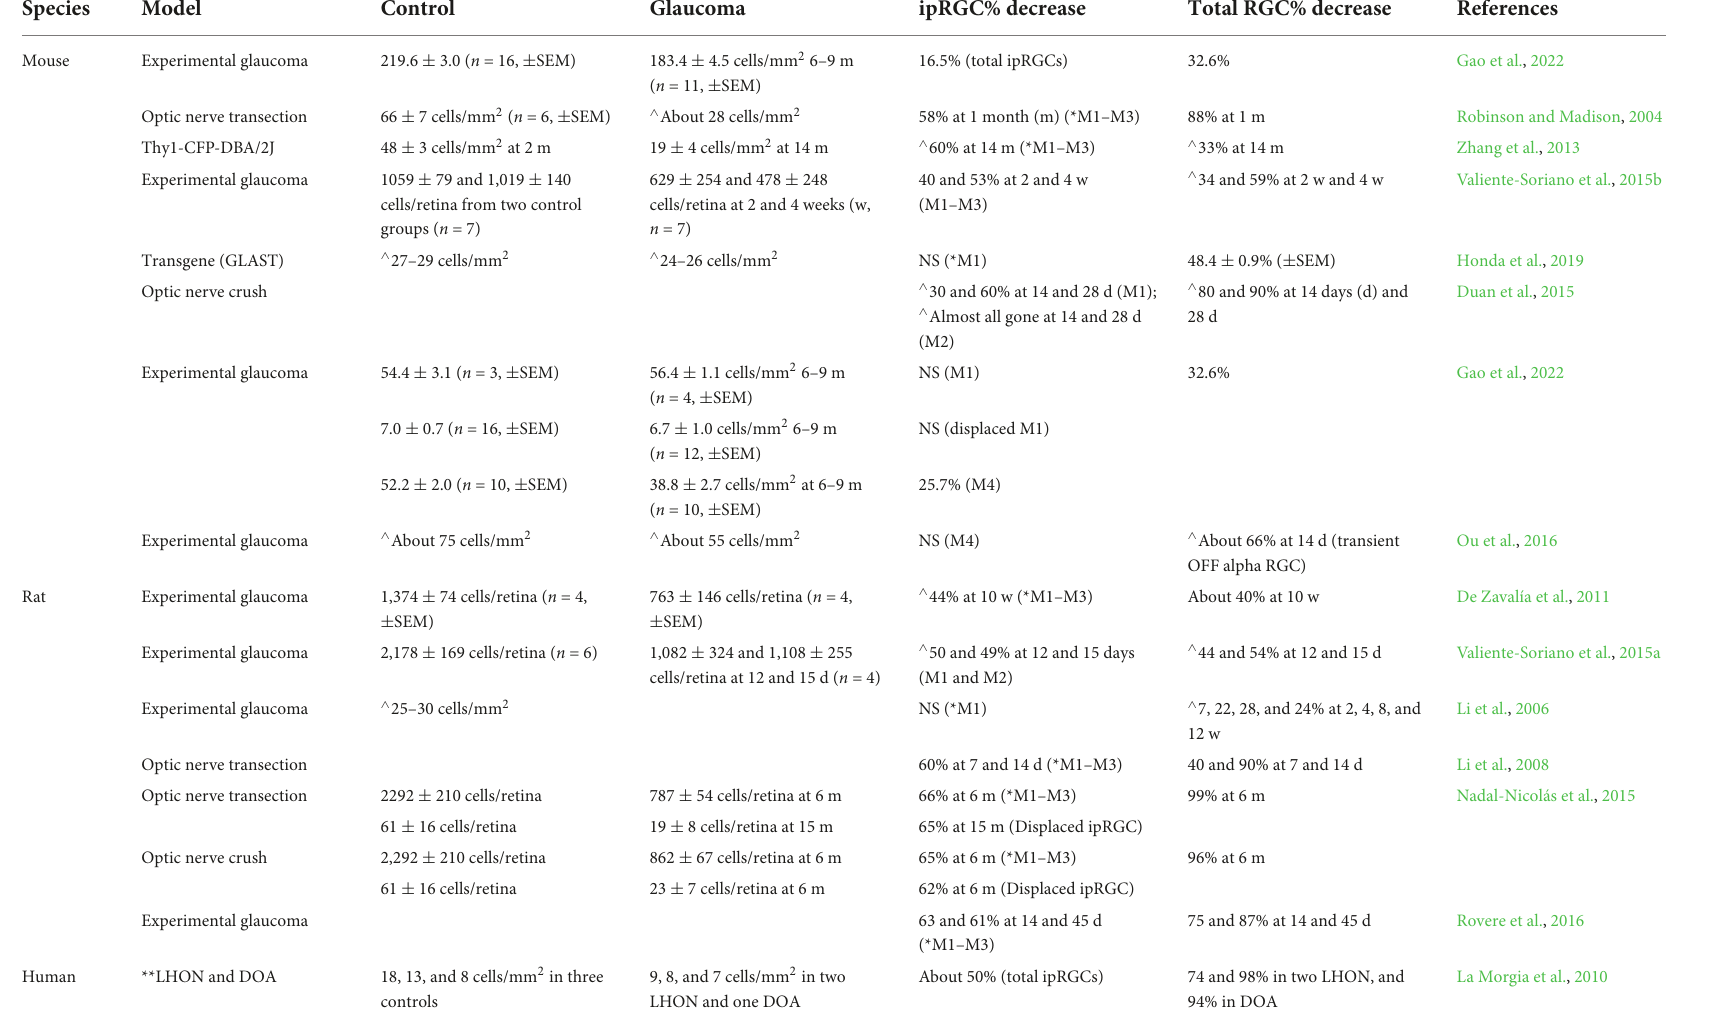
TABLE 2 Intrinsically photosensitive retinal ganglion cell (ipRGC) degeneration in